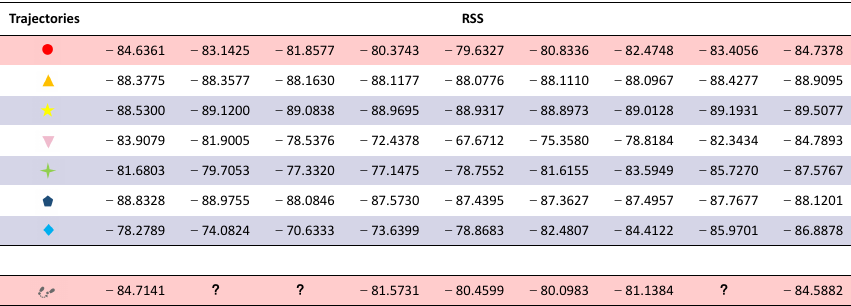
Figure 8. Path Matching Results. The mark “?” represents a missing RSS value.